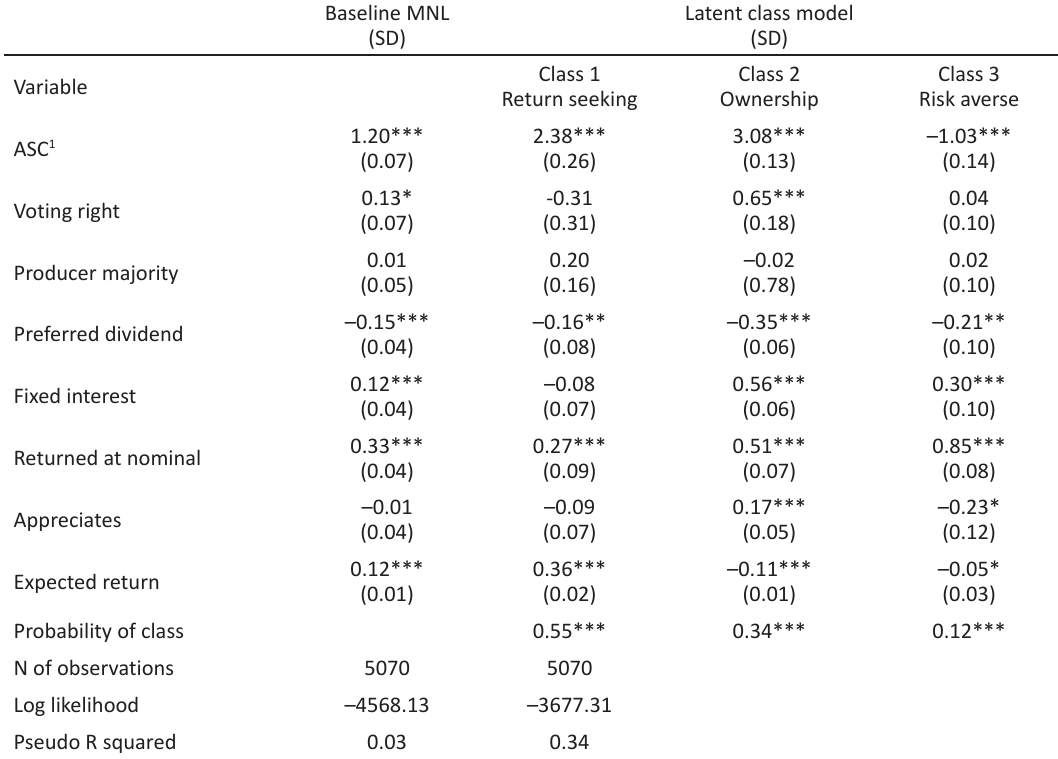
Table 3. Estimates of the multinomial and latent class